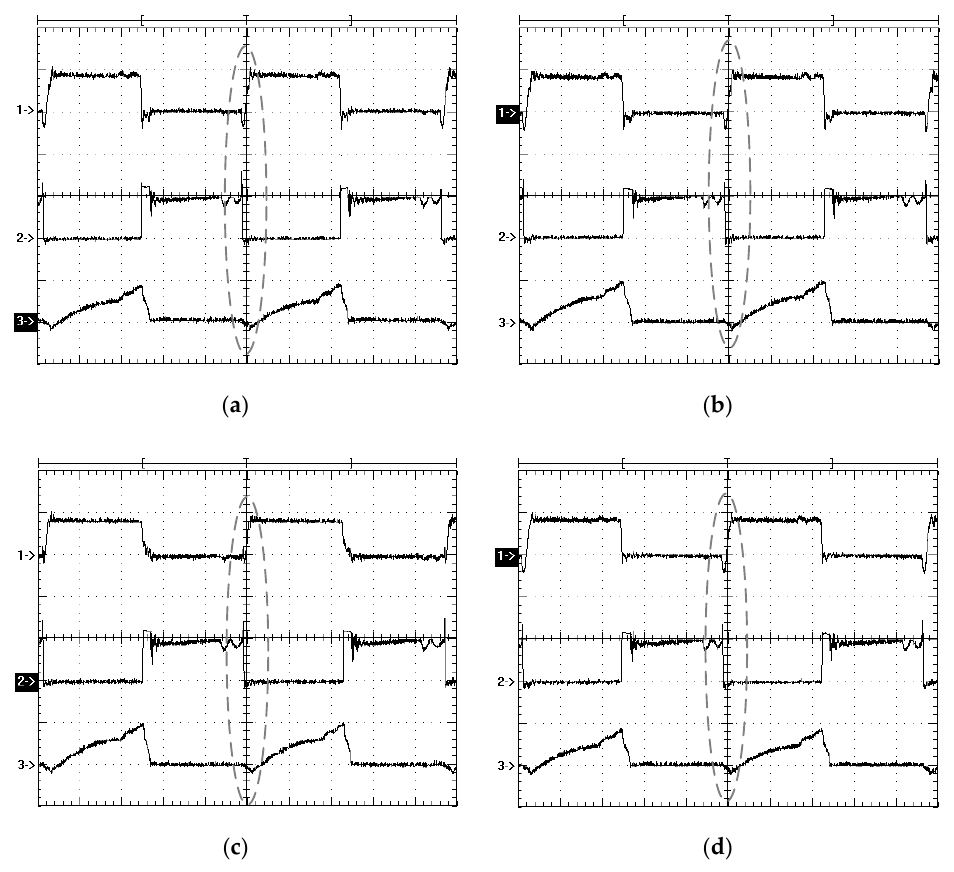
Figure 14. Measured waveforms of power devices Q 1 ~ Q 4 under reverse power operation and 20% load ( a ) Q 1 waveform ( b ) Q 2 waveform ( c ) Q 3 waveform ( d ) Q 4 waveform (v Q 1, g – v Q 4, g : 10 V/div; v Q 1, d – v Q 4, d : 50 V / div; i Q 1 – i Q 4 : 20 A / div; time: 2 µ s)